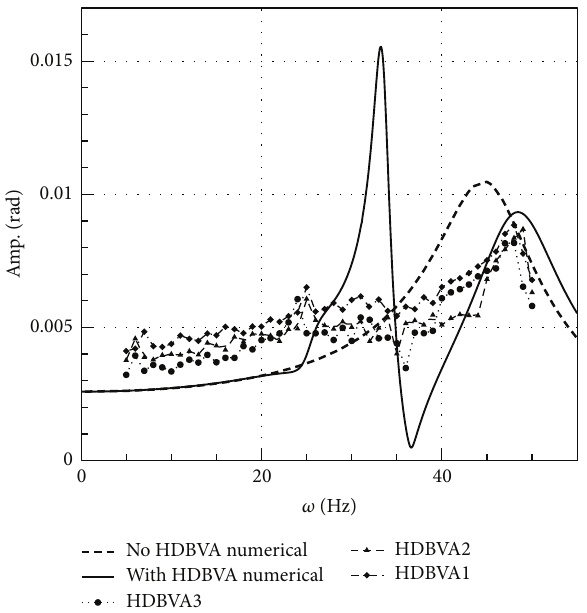
Figure 33: Frequency response of 𝜃 𝑌 DOF of case Figure 10(d), HDBVAs start at the far-from-force point.